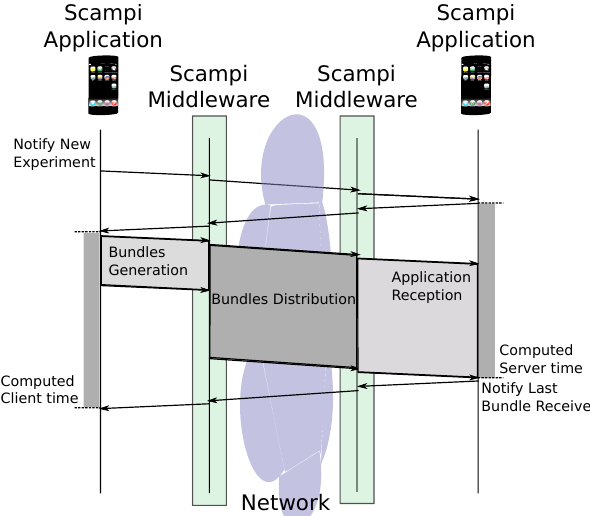
Figure 7: Bundles sent to measure the Scampi through- put.